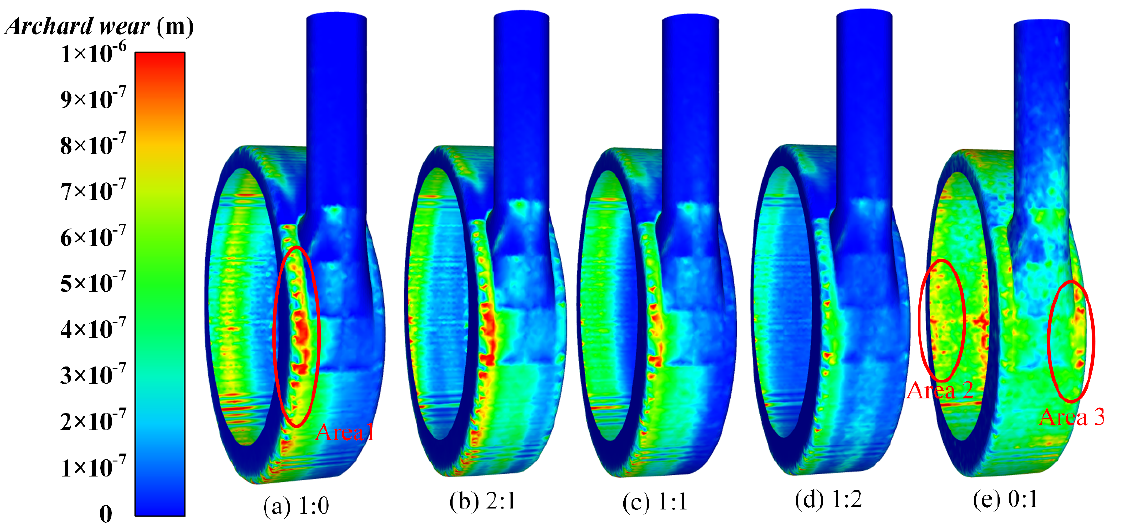
Figure 12. Volute wear distribution under different particle ratios.